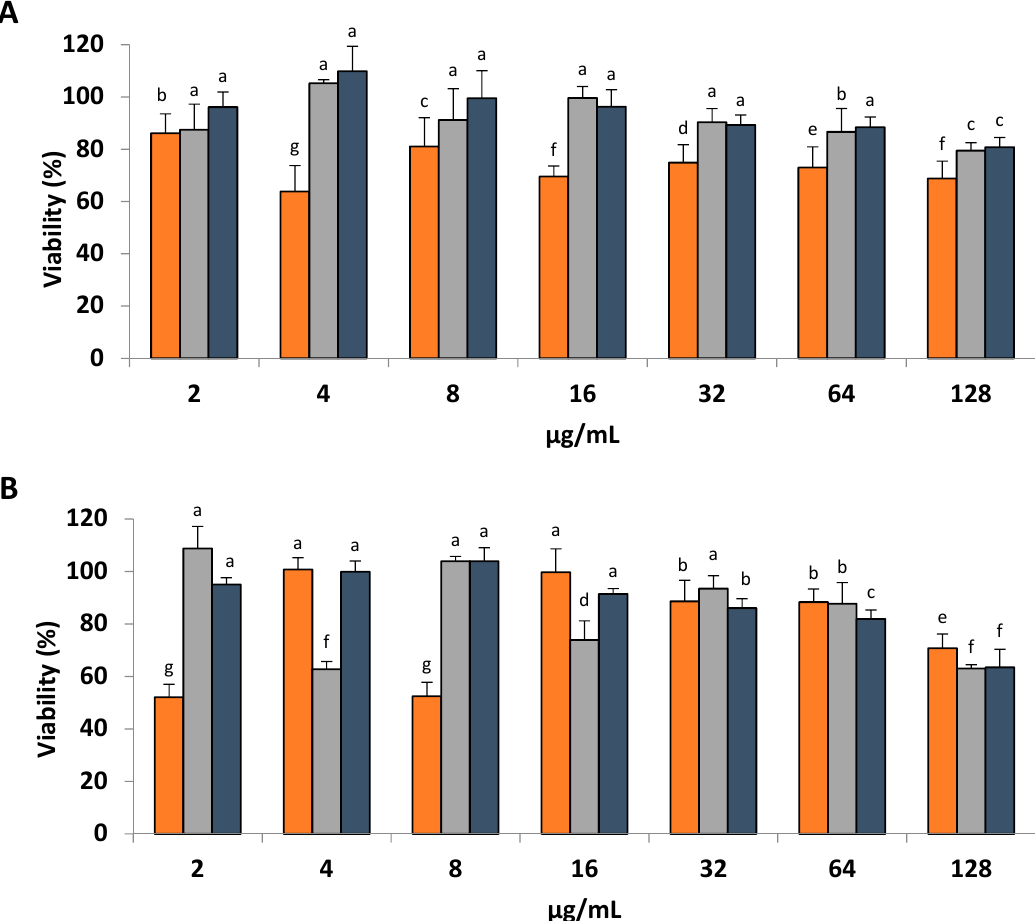
Figure 3. Cell proliferation assay. Viability of ( ) HDFa, ( ) CaCo-2 and ( ) MCF7 cells cultured with different concentrations of ( A ) SSE and ( B ) HPLC Fraction c is presented as a percentage of the formazan signal recorded at 490 nm compared to untreated cells. According to the Tukey’s test performed, significantly different means are identified with different significance letters.